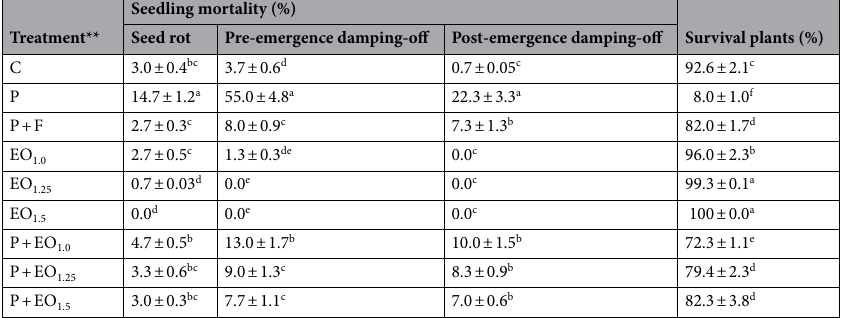
Table 3. Disease assessment of sorghum seedlings infected with Fusarium solani in response to treating with lavender essential oil at different concentrations. Values followed by the same letter are not significantly different according to Duncan’s multiple range test ( P ≤ 0.05), each value represents the mean of 3 replicates ± SD. **C: untreated control, P: infected with F. solani , P + F: infected with F. solani and treated with chemical fungicide (Rhizolex-T), EO 1.0 , EO 1.25 , EO 1.5 : treated with lavender EO at 1.0, 1.25, and 1.5% respectively, P + EO 1.0 , P + EO 1.25 , and P + EO 1.5 : infected with F. solani and treated with lavender EO at 1.0, 1.25, and 1.5%, respectively.